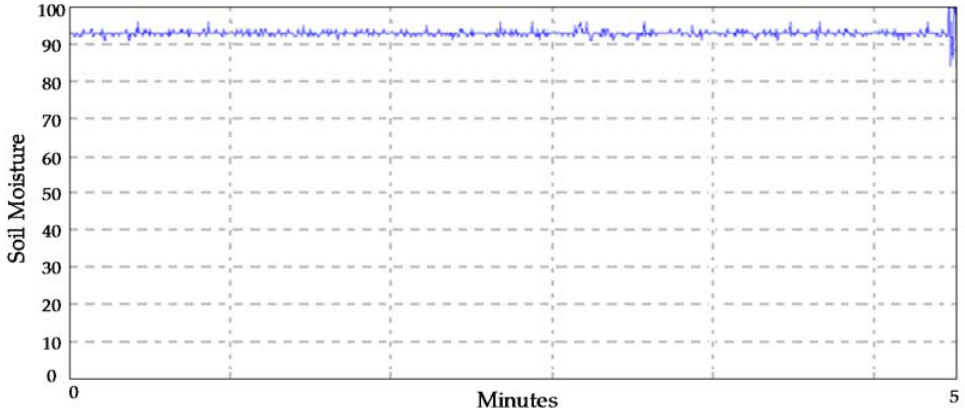
Figure 12. Soil moisture for Irrigation 9.